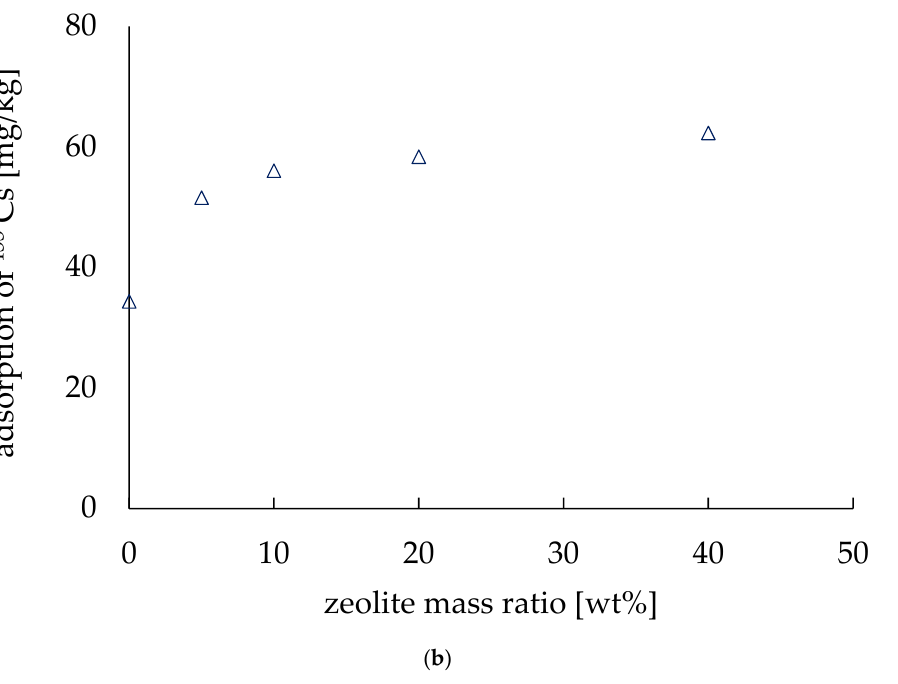
Figure 7. Adsorption of 133 Cs. ( a ) Adsorption depends on the pressure applied during fabrication. ( b ) Adsorption varies with the amount of zeolite.